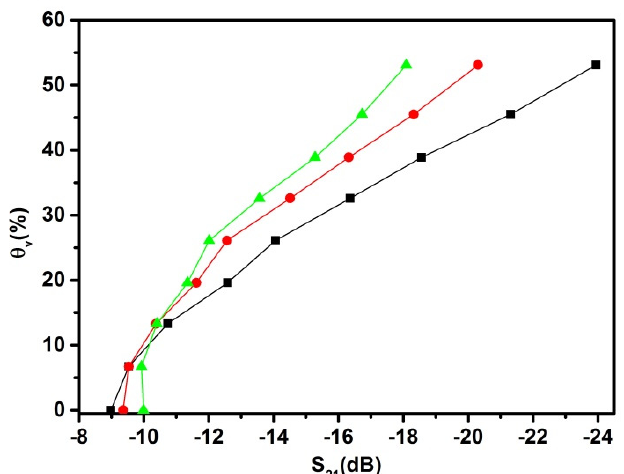
Figure 8. Influence of temperature on the θ V measurements using attenuation S 21 . The porous medium used was Nullerde, and the temperature set up for this experiment was 13.0 ± 0.5 (black squares), 26 ± 0.5 °C (red dots) and 39.0 ± 0.5 °C (green triangles).